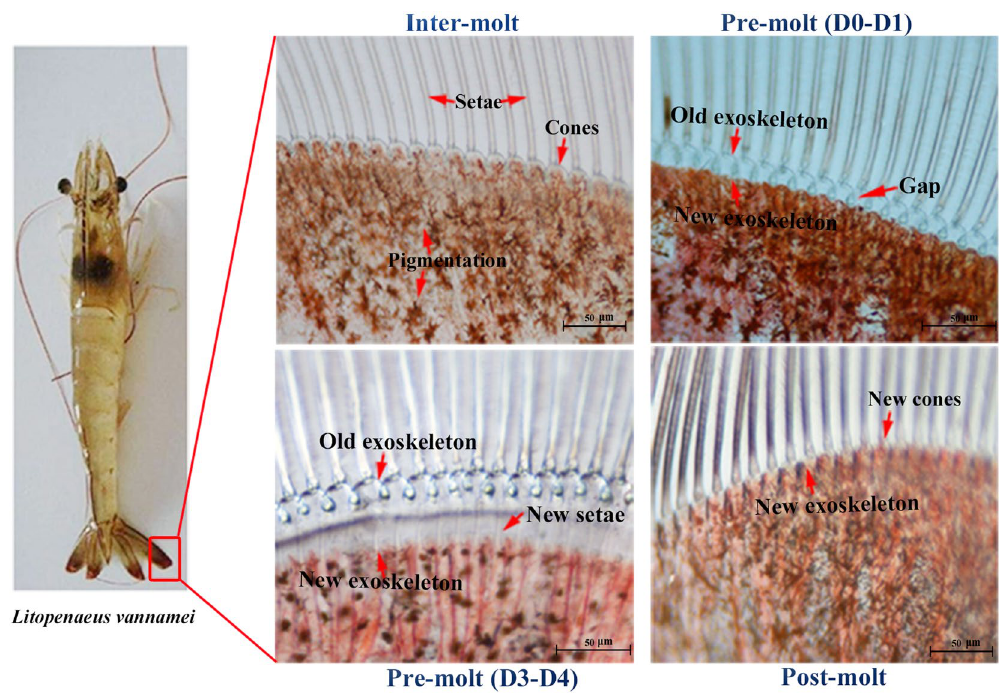
Figure 6. Morphological changes of shrimp uropods during moulting stages under a light